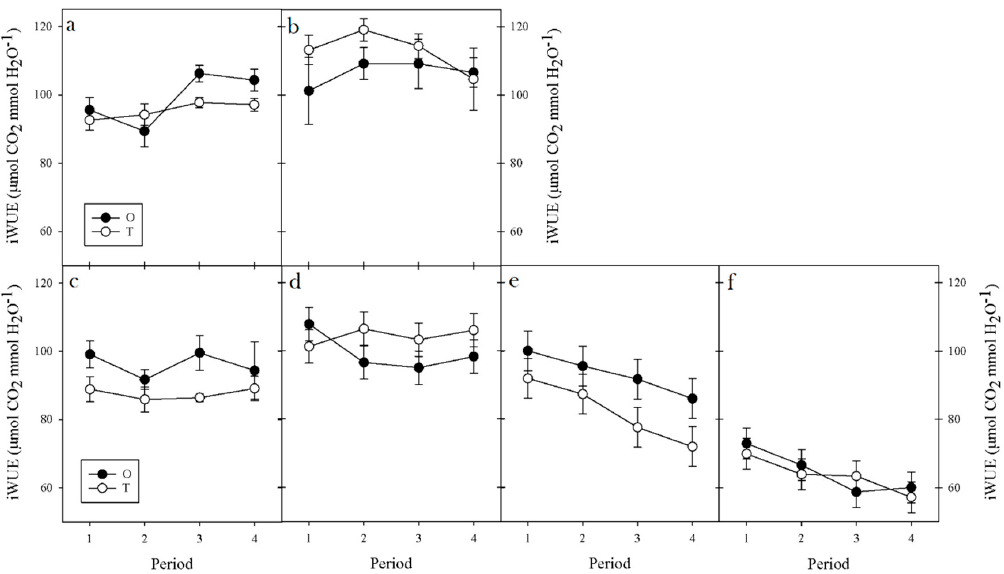
Figure 2. Intrinsic water use efficiency (iWUE, µmol CO 2 mmol H 2 O − 1 ) for: ( a , c ) Douglas-fir; ( b , d ) western redcedar; ( e ) western hemlock; and ( f ) grand fir trees growing under contrasting vegetation management treatments on a site located in the Cascade Foothills (upper panels) and Coast Range (lower panels) of western Oregon. O: no post-planting vegetation control (open symbol); T: sustained vegetation control during first five years post planting (filled symbol). Error bars represent standard error.